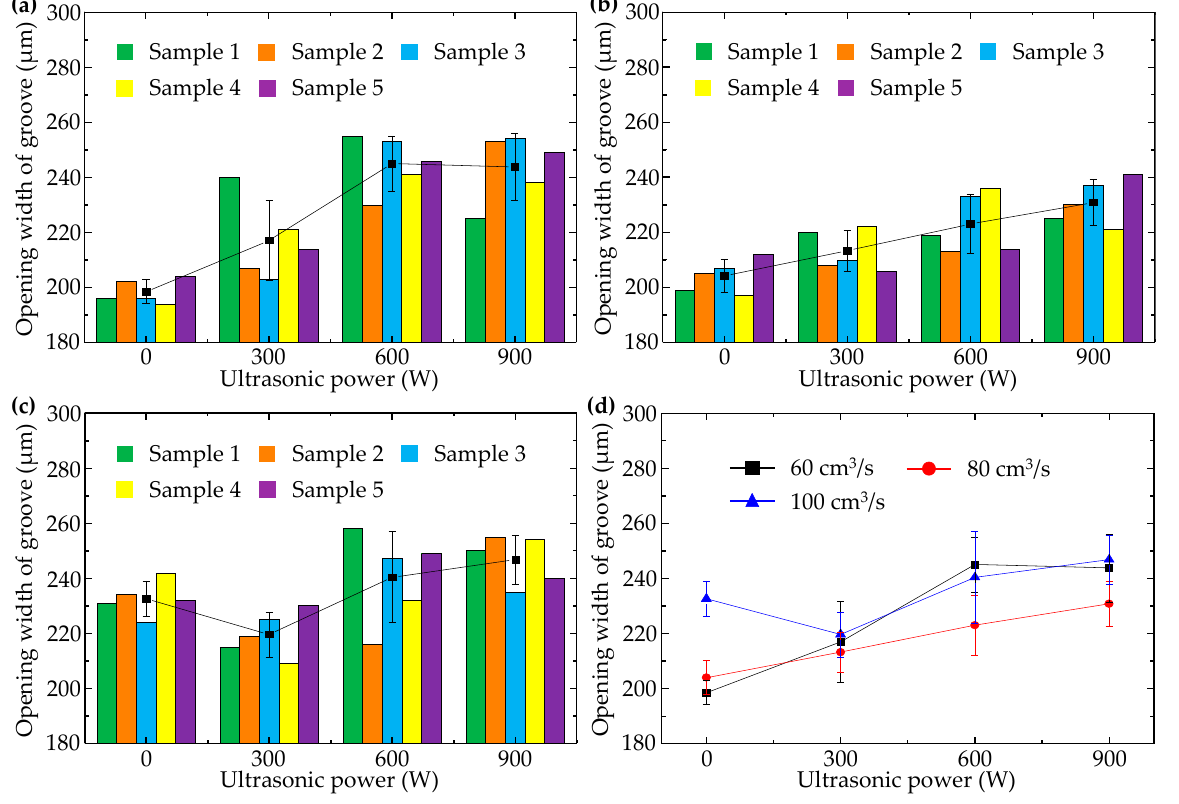
Figure 6. Variation of opening width of the longitudinal micro groove with ultrasonic power when injection pressure was 60 MPa and injection speeds were ( a ) 60 cm 3 /s, ( b ) 80 cm 3 /s, and ( c ) 100 cm 3 /s. ( d ) Comparison of the average values of each group.